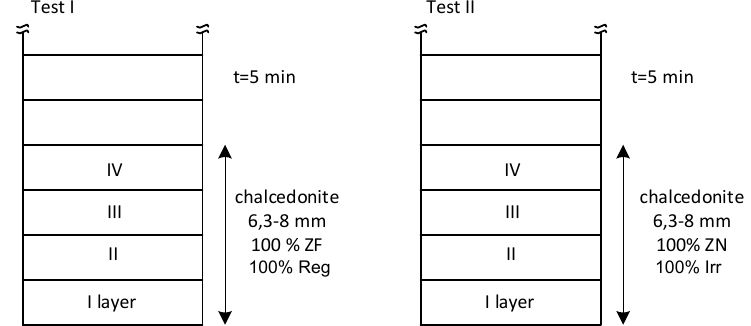
Figure 4. Scheme of investigations for testing of regular and irregular particles in particle size fraction